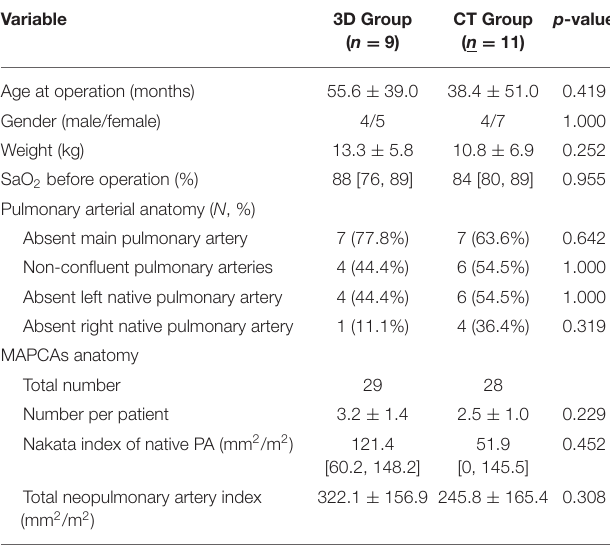
TABLE 1 | Preoperative